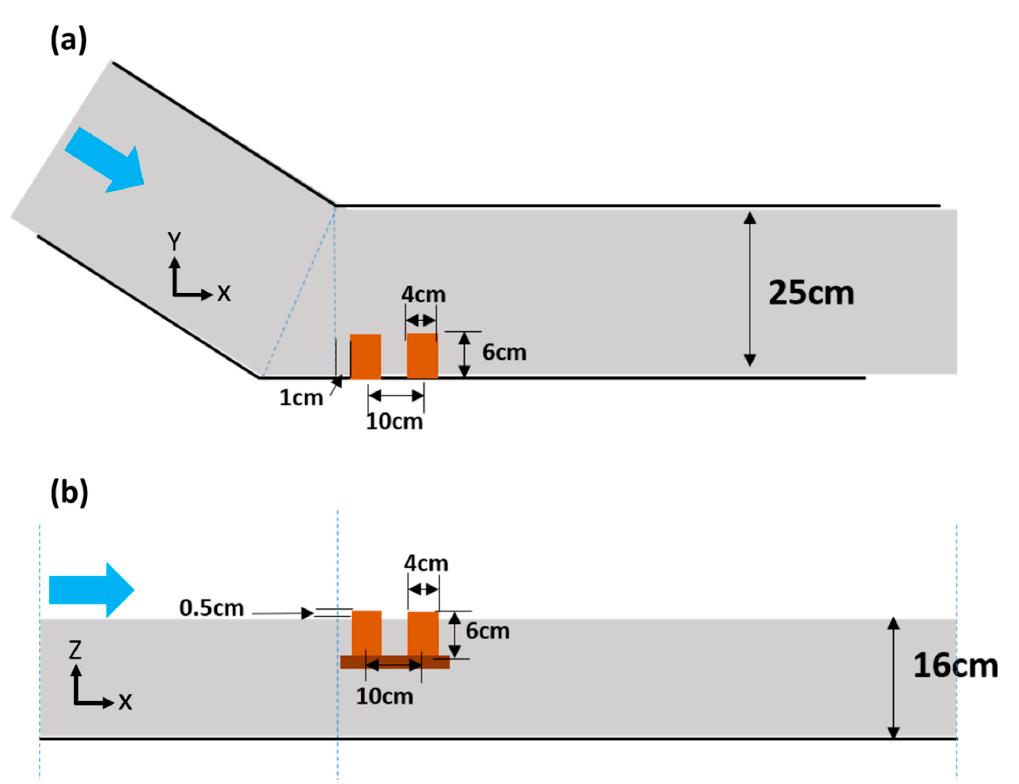
Figure 3. Spur ( a ) top view, and ( b ) side view.